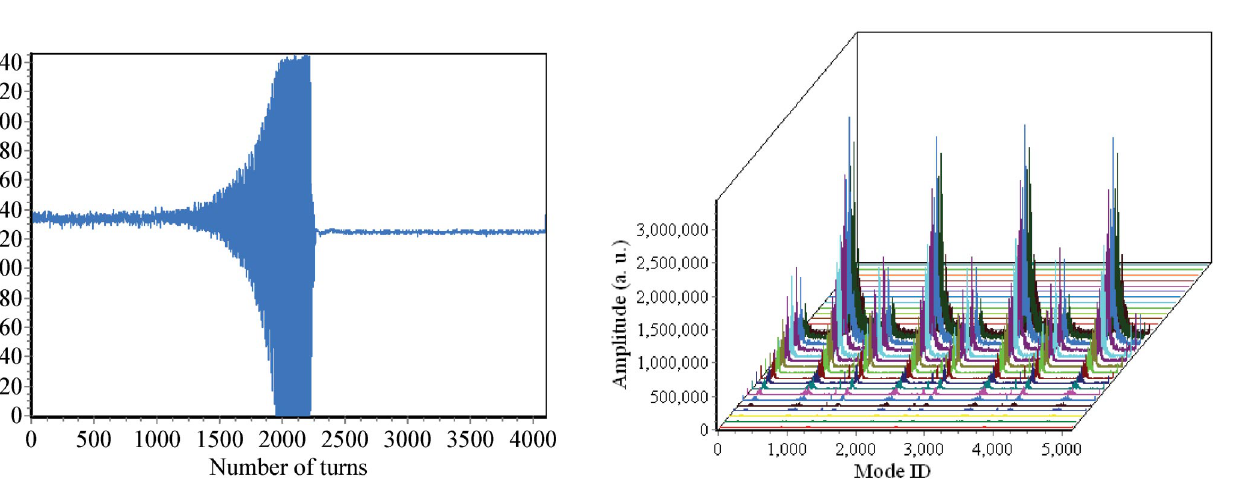
FIG. 4. (Color) Time evolution of the horizontal unstable modes when all the solenoids were turned off.